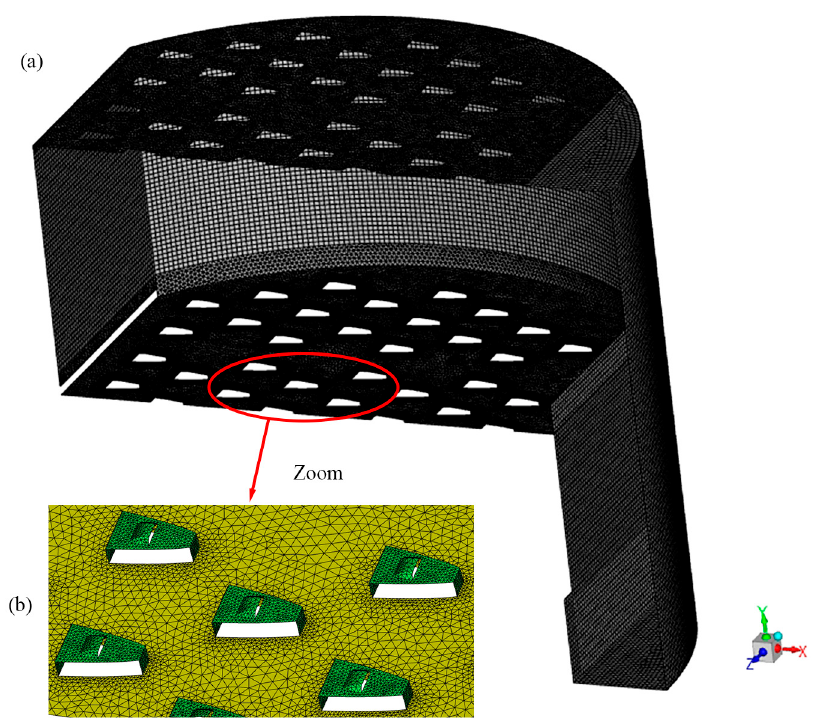
Figure 3. Illustration of the computation mesh: ( a ) Whole valve tray space mesh; ( b ) The bottom mesh of the valve tray.